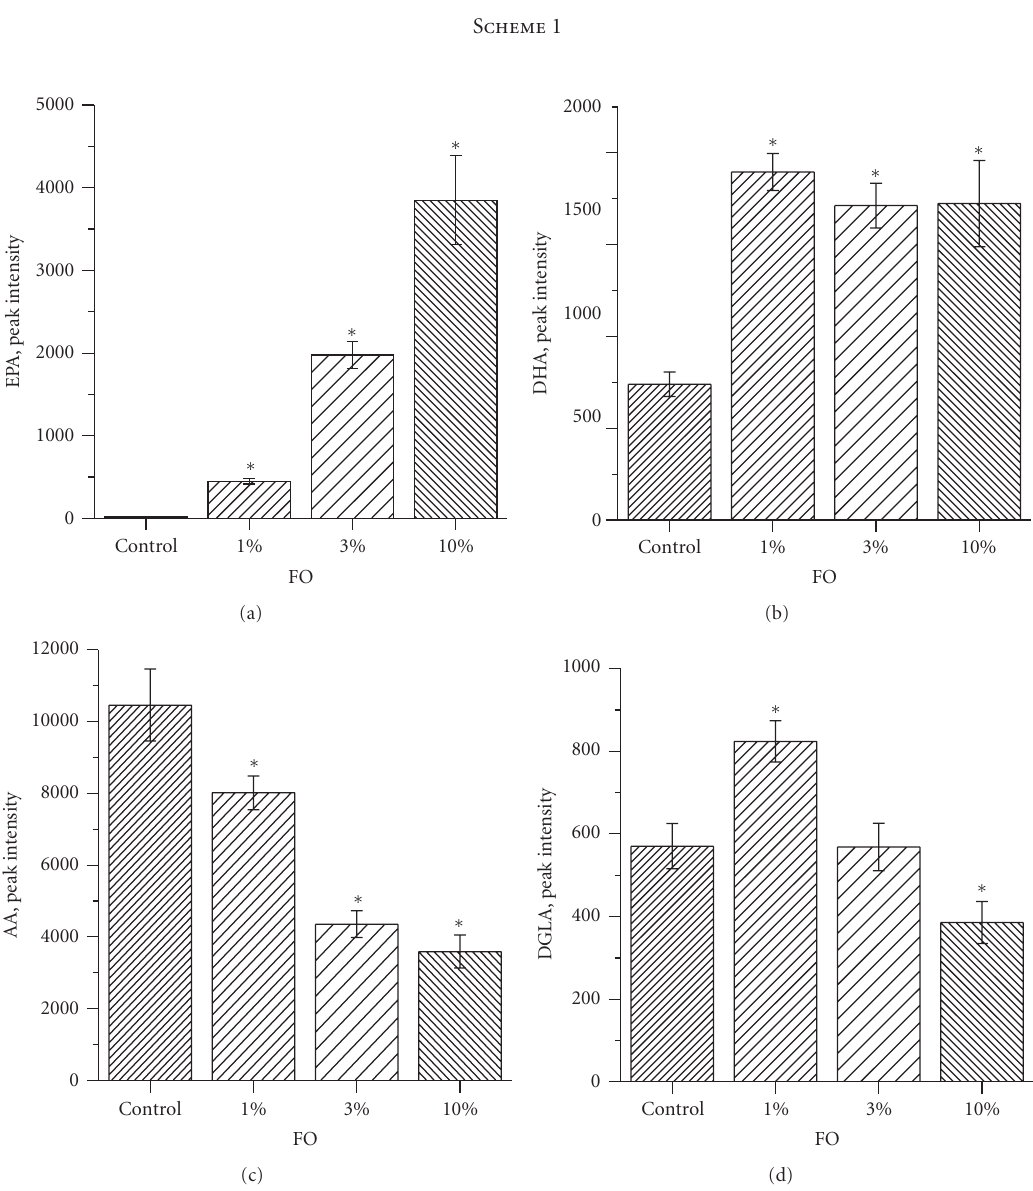
Figure 1: E ff ect of dietary FO on plasma level of EPA, DHA, AA, and DGLA. Data are expressed as means of group of n = 6, ± SEM . Statistical significance between tested samples was determined by a two-sample t -test, level of significance was set at P < 0 .